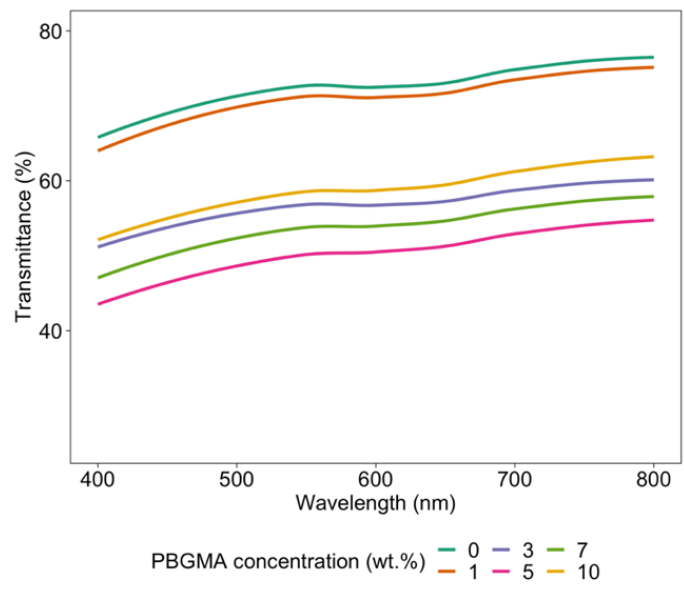
Figure 7. Transmittance curves obtained by UV–Vis spectrometry at various PBGMA contents after 2 passes under UV irradiation.